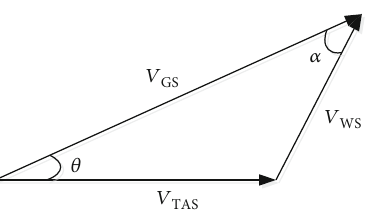
Figure 3: Apparent wind vector